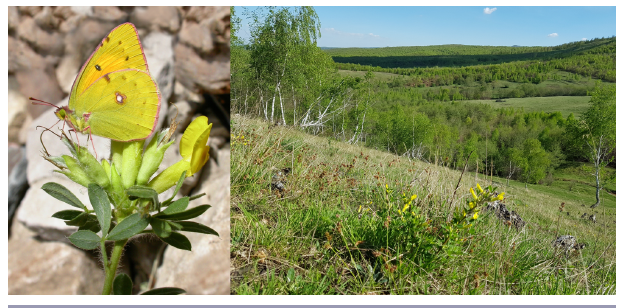
Fig. 2. Colias myrmidone female on its host plant Chamaecytisus sp. (left, photo credit: M. Gascoigne-Pees); and its typical habitat in Transylvania (right, photo credit: M.